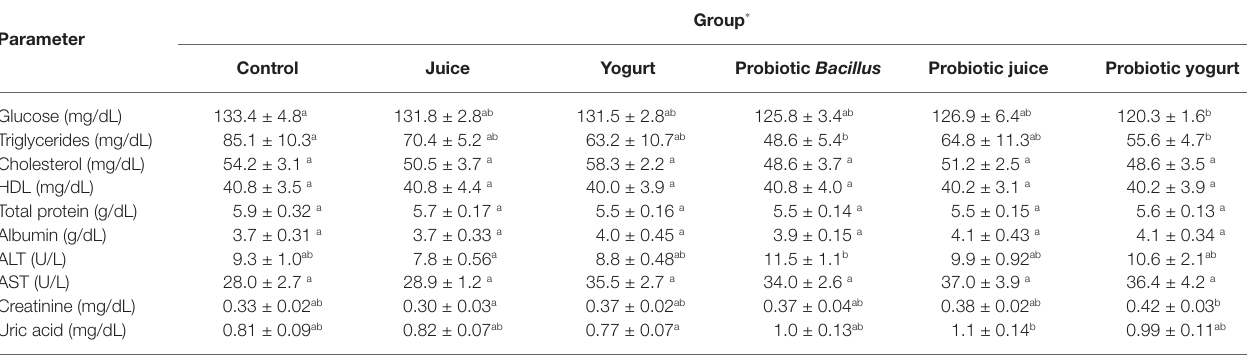
TABLE 2 | Effect of probiotic yogurt and probiotic juice consumption during 21 days on healthy Wistar male rats’ biochemical parameters.